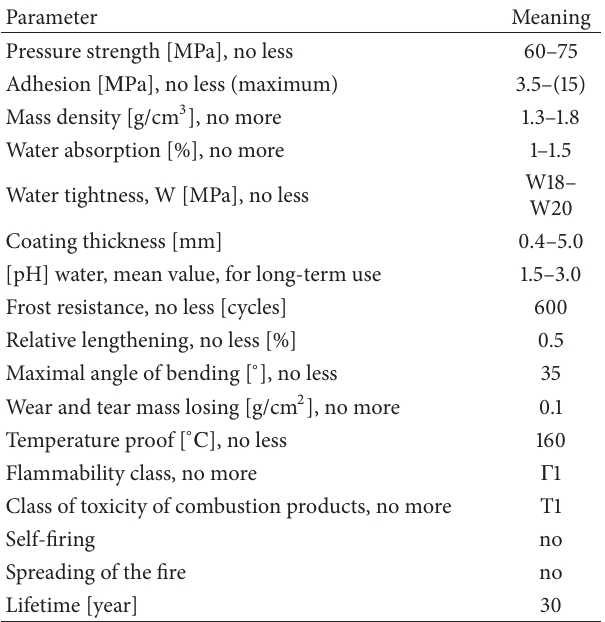
Table 1: Main parameters of the EpoxyPAN coating